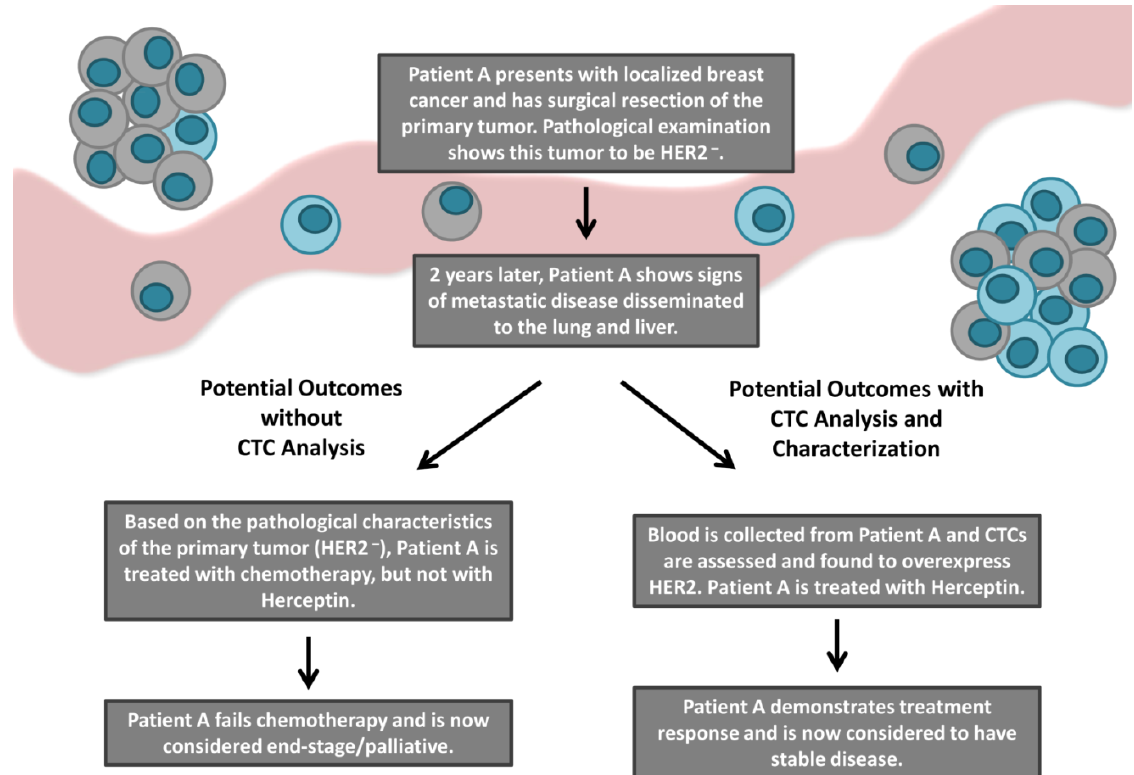
Figure 2. An overview of the current and potential patient outcomes following the incorporation of CTC molecular characterization into the clinic. The majority of cancer-related deaths result from the development of metastatic disease. Although metastatic lesions can be highly heterogeneous compared to their primary tumor counterparts, current treatment decision making is typically based on characteristics of the primary tumor, as routine metastatic biopsy is not clinically feasible. CTCs have been suggested as a surrogate to metastatic biopsy. Characterization of therapeutic target molecules such as HER2 on CTCs may increase the availability of targeted therapies ( i.e. , the HER2 targeting agent Herceptin) to patients previously considered ineligible based upon the characteristics of their primary tumor. Ultimately, utilization of CTC analysis and characterization in the clinic may predict response to targeted therapies and improve patient